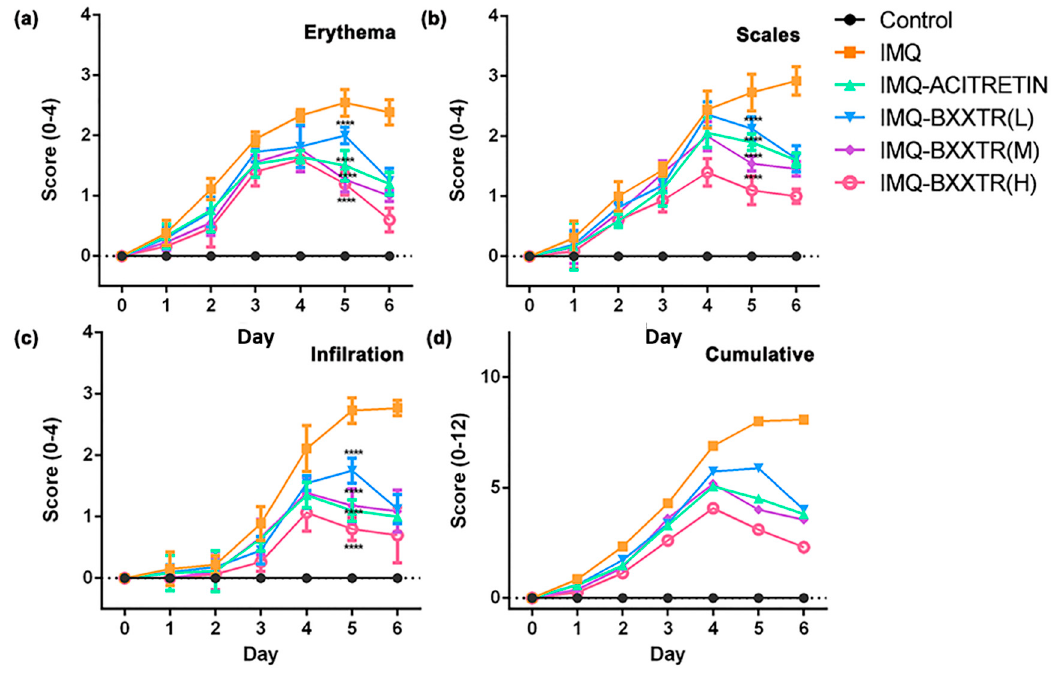
Figure 1. BXTTR treatment reduces IMQ-induced psoriatic-like cutaneous lesions in BALB/c mice on the back skin. ( n = 10 for each group, black = control group, orange = IMQ group, cyan = IMQ-ACITRETIN group, blue = IMQ-BXXTR (L) group, purple = IMQ-BXXTR (M) group, pink = IMQ-BXXTR (H) group). Erythema, scales, infiltration of the back skin were scored on days 0–6 using the Psoriasis Area Severity Index (PASI) to assign a score of 0–4 to each animal and thereby assess the effects of daily treatment with IMQ cream and vehicle cream. ( a ) Erythema: data points are presented as group means ± SD; ( b ) scales: data points are presented as group means ± SD; ( c ) infiltration: data points are presented as group means ± SD; ( d ) cumulative score: erythema plus scales plus thickness. **** p < 0.0001 vs. IMQ.